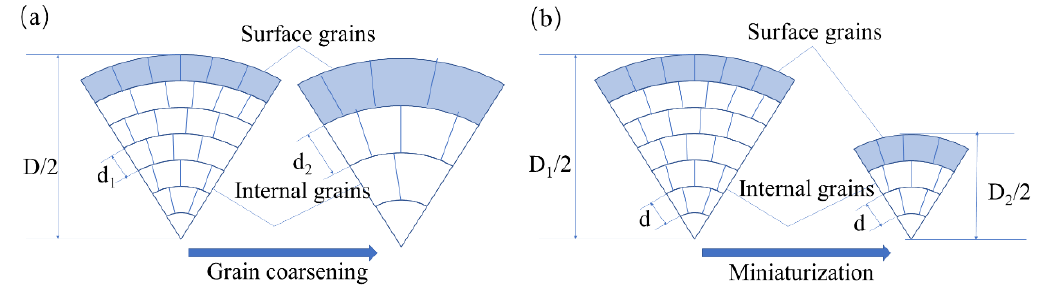
Figure 5. Grain size effects and specimen size effects with the decreasing of the scale. ( a ) Grain size effects and ( b ) specimen size effects.